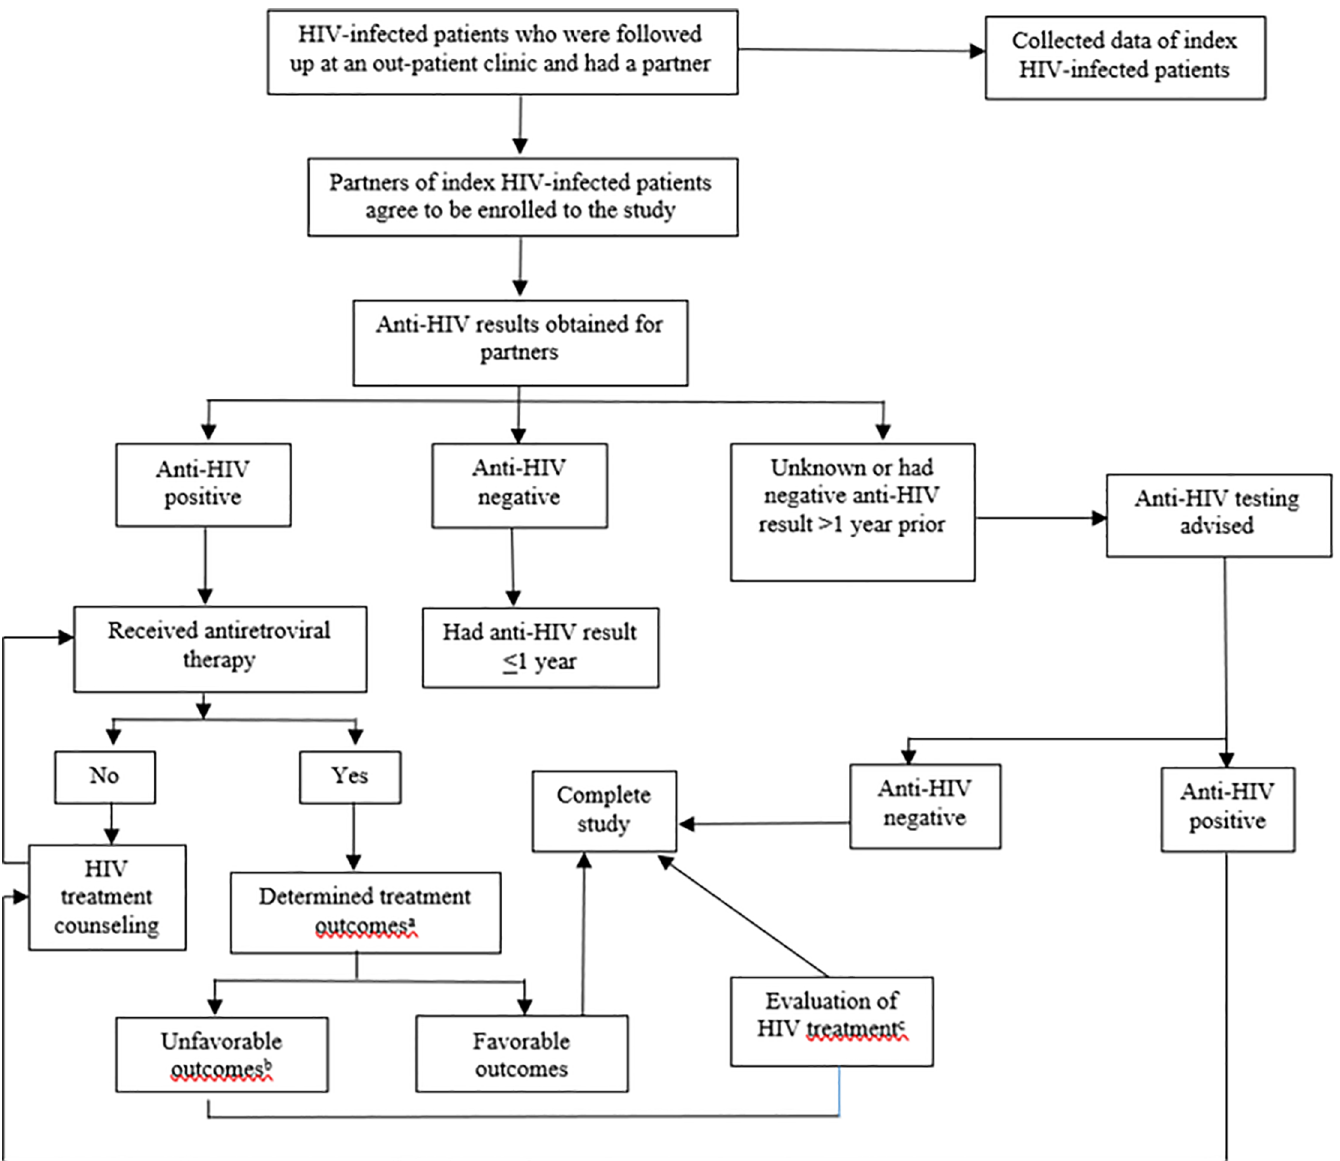
Fig 1. Study flowchart. a adherence, adverse drug reaction, CD4 count, and HIV RNA; b adherence < 95%, had adverse drug reaction, or detectable HIV RNA ( > 200 copies/mL) in the prior 6 months; c HIV prevention and adherence counselling; repeated HIV RNA and/or HIV genotype (if HIV RNA > 1,000 copies/mL).